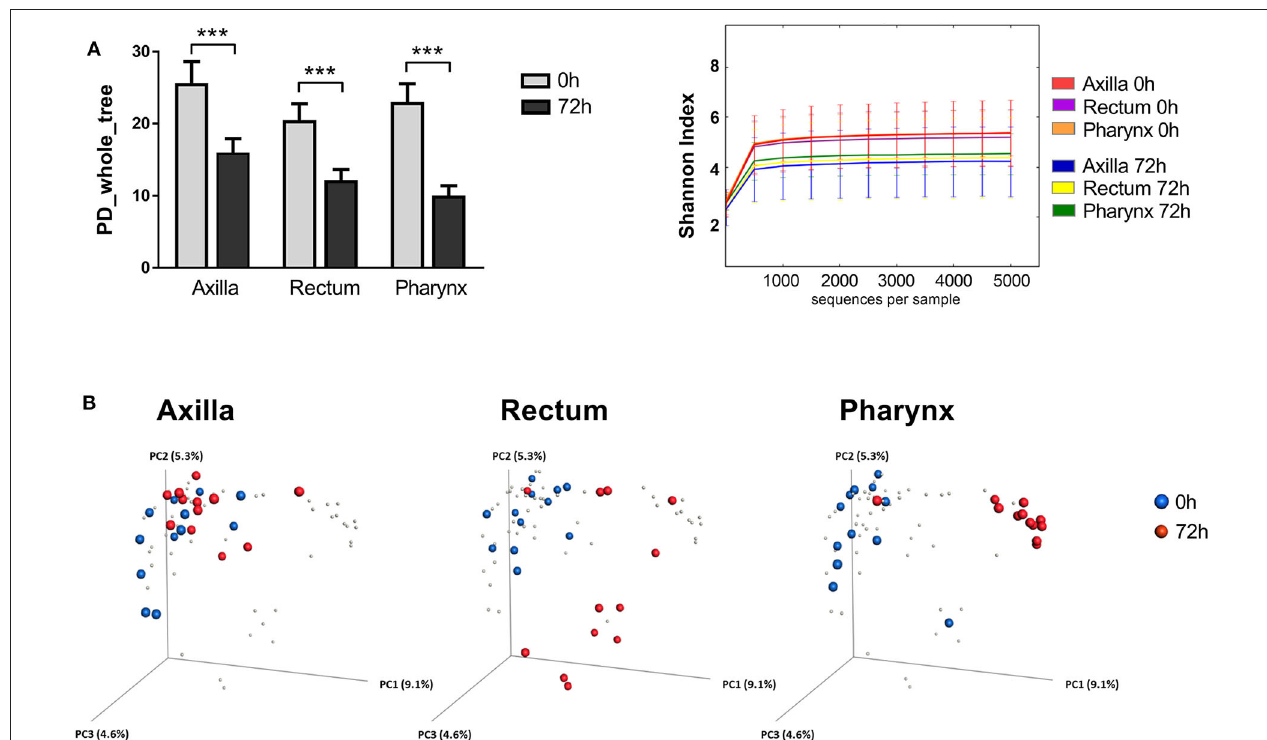
FIGURE 2 | Diversity metrics of the newborn’s microbial communities at the time of birth and after 72h of life. (A) Comparison of the α -diversity of the microbial communities from axilla, rectum and pharynx between the two analyzed time points (0 vs. 72h). Shown are the phylogenetic diversity (left) and the Shannon index (right), respectively (*** p < 0.005). (B) PCoA analysis of the newborn microbiome. Each point corresponds to a community colored according to the time point of sampling (0h in blue vs. 72h in